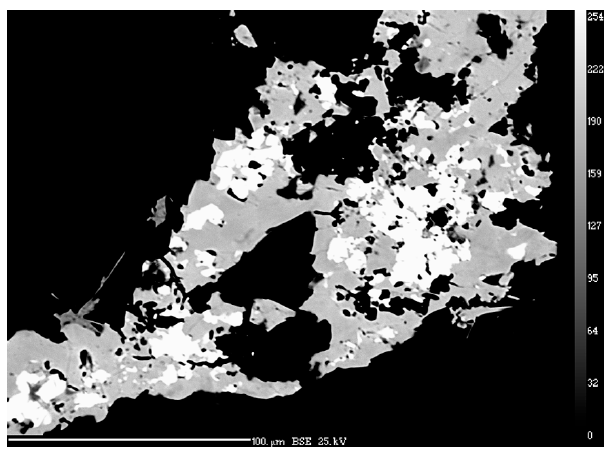
Figure 72. Hakite aggregates (grey) with abundant earlier grains of tiemannite (white); tiny acicular crystals of the youngest antimonselite (dark grey) are on the bottom-left of the figure. BSE photo. P ř íbram, a dump of the shaft 16. Photo by J. Sejkora and P. Škácha.